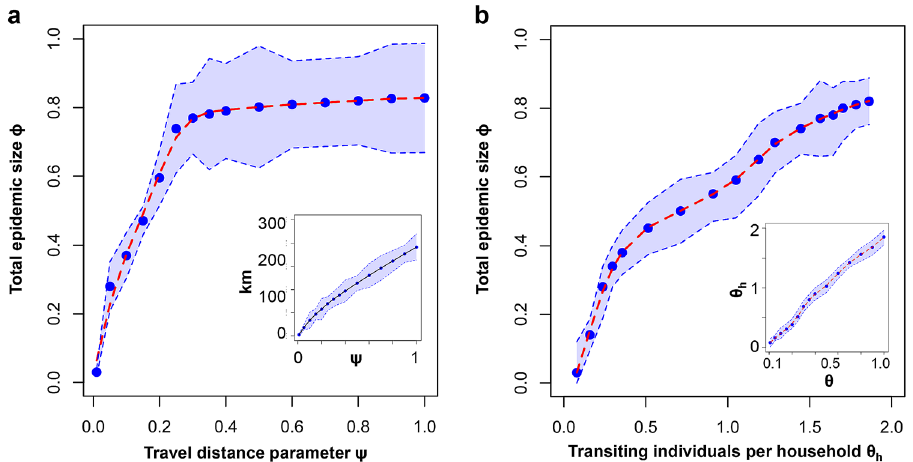
Figure 4. Total epidemic size φ averaged over 2000 simulations, ( a ) as a function of the travel distance parameter (cid:31) , respectively ( b ) as a function of the travel frequency, normalized at household level (cid:31) h . ( a ) Epidemic size φ exhibits a clear phase transition starting with minimal increases in (cid:31) , which, in turn, enables non-local spreading. (Inset) Linear relationship between (cid:31) and the daily travel distance (in km), averaged over all individuals in the GHPM model for Germany (sized roughly 600 × 750 km). ( b ) Epidemic growth shows no visible phase transition in response to increases in (cid:31) h . (Inset) Linear relationship between (cid:31) and (cid:31) h , averaged over all households. The blue regions indicate 95%